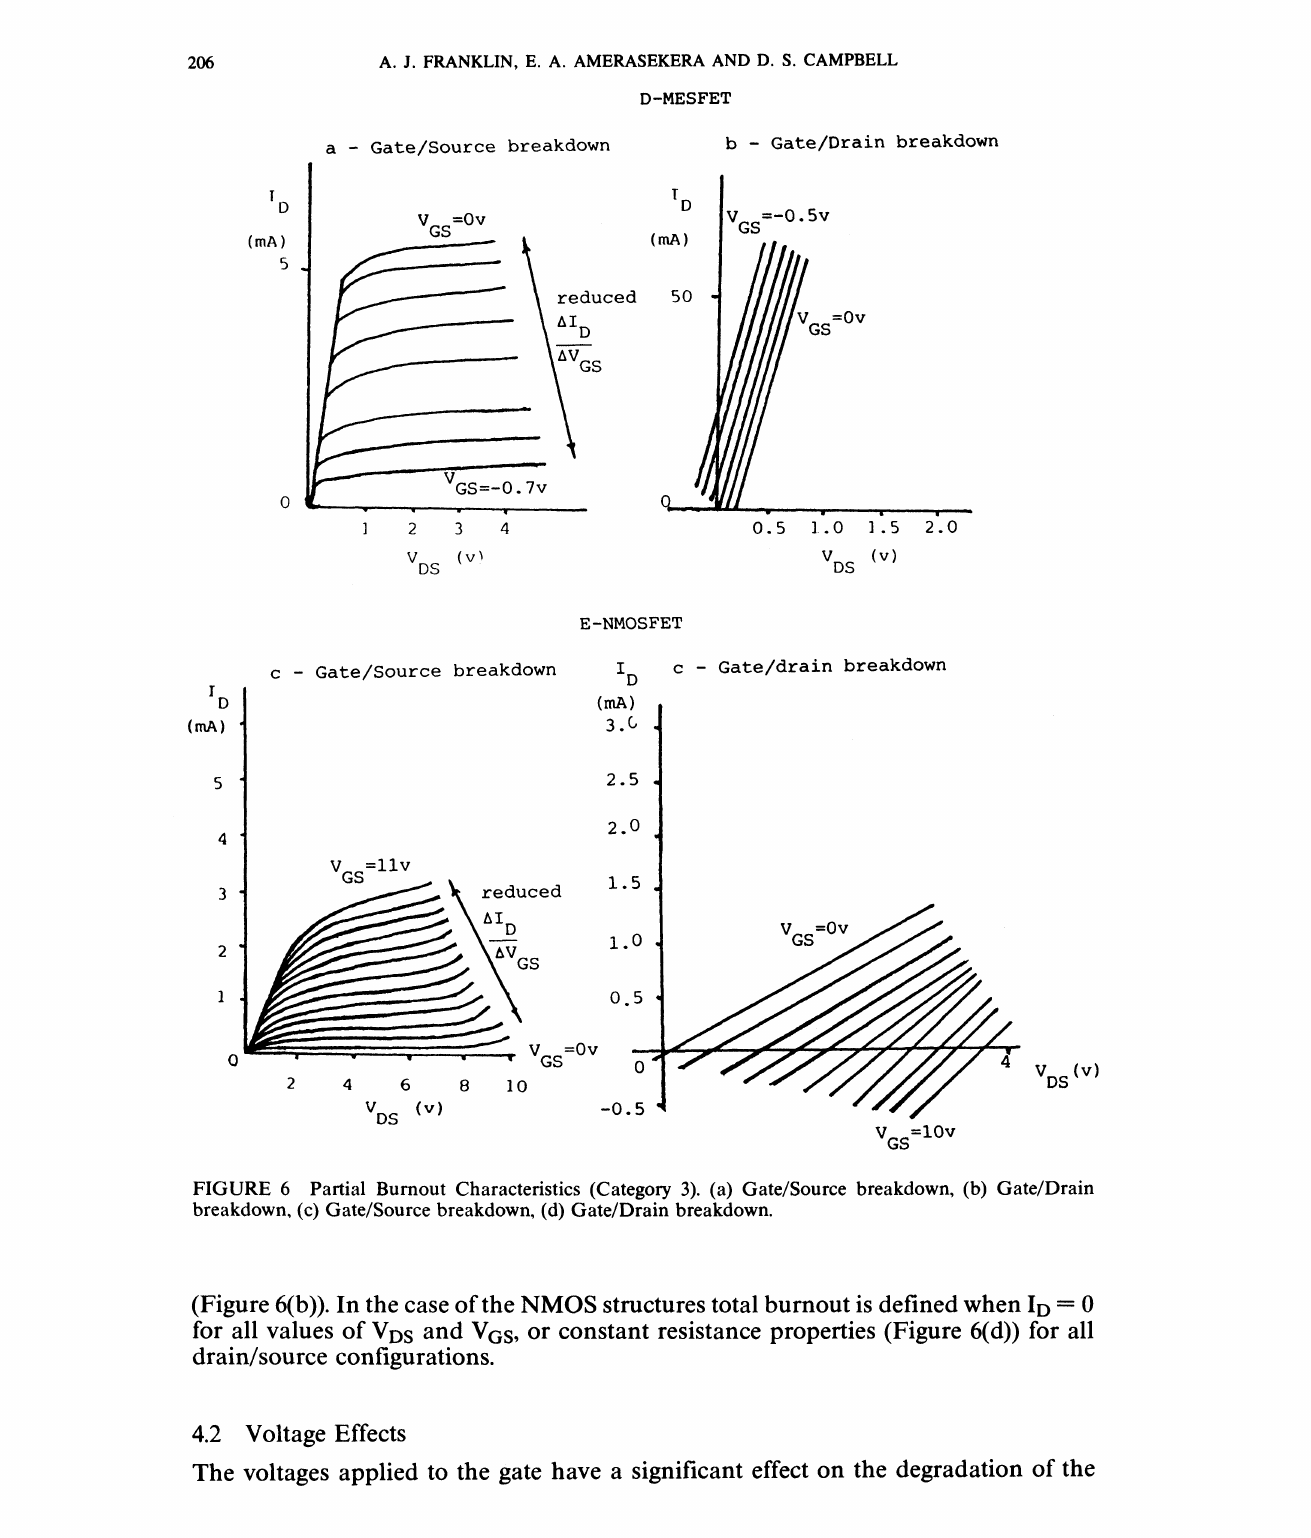
FIGURE 6 Partial Burnout Characteristics (Category 3). (a) Gate/Source breakdown, (b) Gate/Drain breakdown, (c) Gate/Source breakdown, (d) Gate/Drain breakdown.